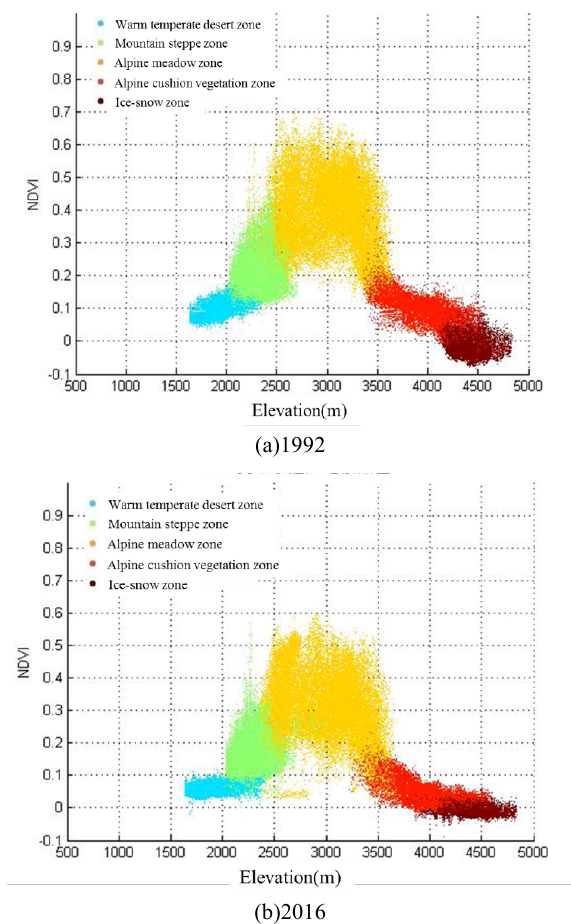
Figure 2. Scatter plots of Tomur Site in 1992(a) and 2016(b) Based on statistical theory and threshold sliding window, the demarcation elevation of the altitudinal natural zones of the